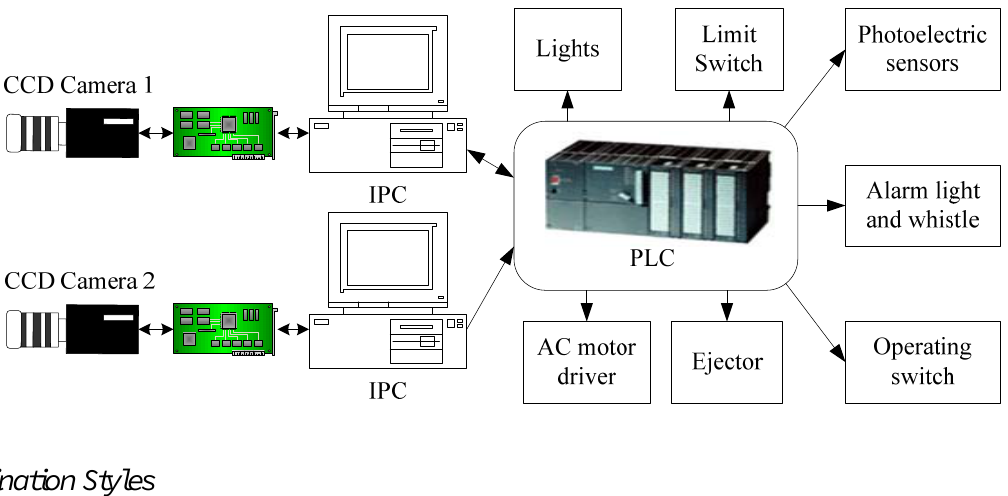
Figure 5. Electric configuration of intelligent inspection